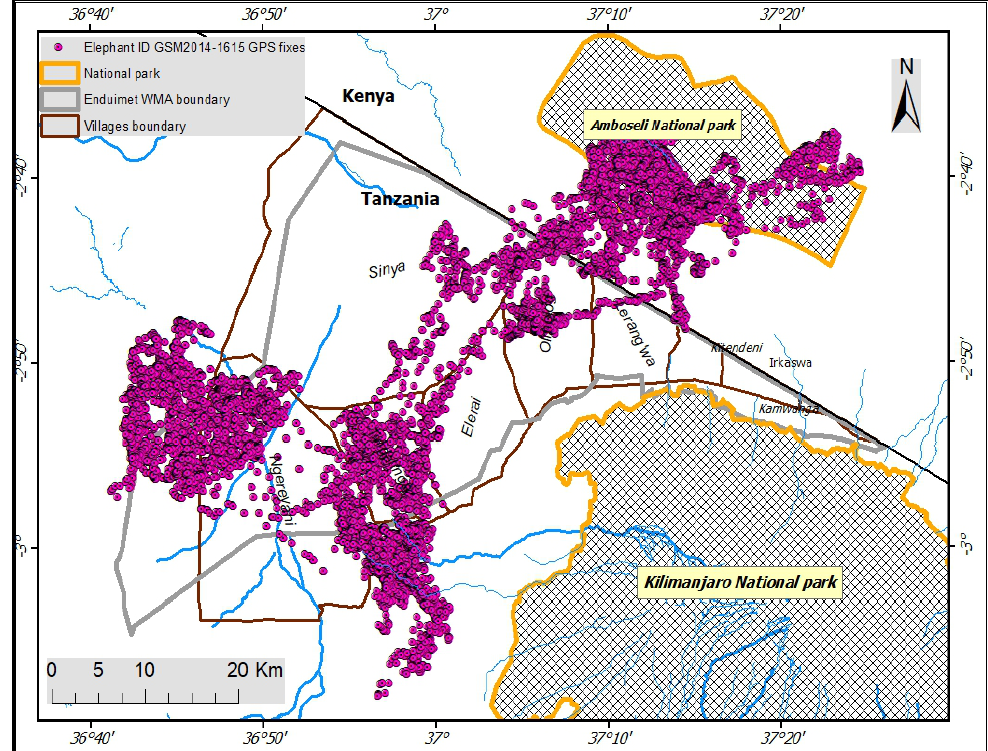
Figure A2. Spatial distribution of one collared elephant with the ID GSM2014-1613 ( n = 17,472) in the Amboseli National Park in Kenya, in the Kilimanjaro National Park and Enduimet Wildlife Management Area (EWMA) in Tanzania. Source: Amboseli Trust for Elephants.